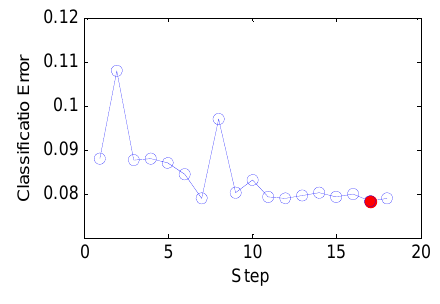
Figure 23. The curve of error versus